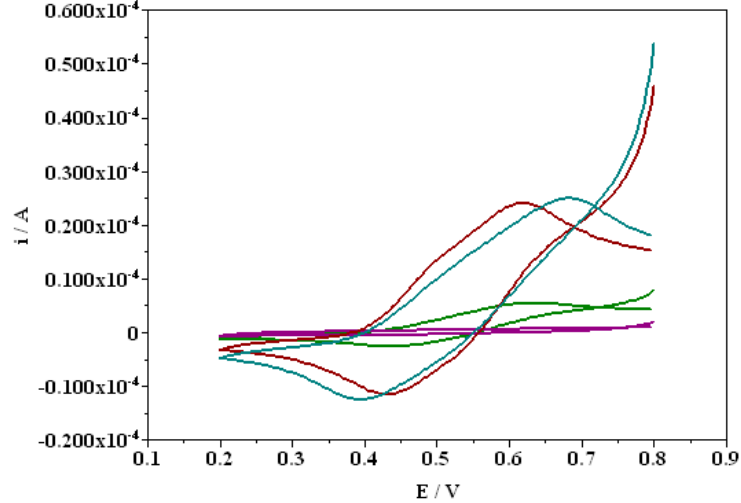
Figure 5. Electrochemical characterization of purified laccase isolated from C. unicolor after incubation with endogenous aspartic-like protease. Aspartic-like protease (violet line); laccase + ABTS (green line), after incubation time of 60 min (red line) and after 120 min (blue line).